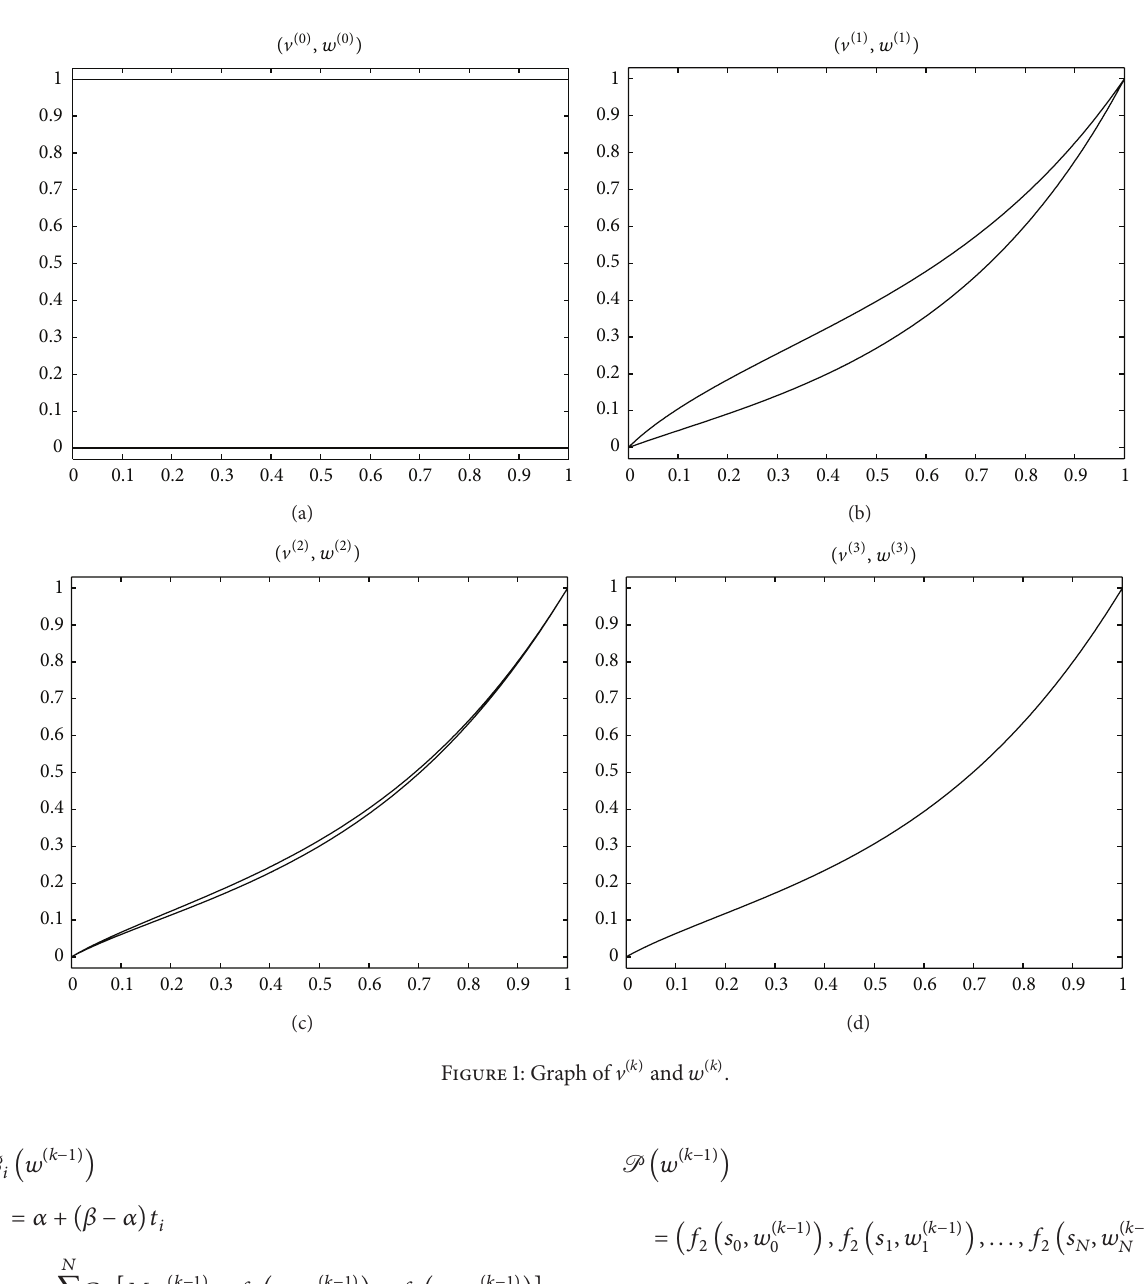
Figure 1: Graph of V (𝑘) and 𝑤 (𝑘)